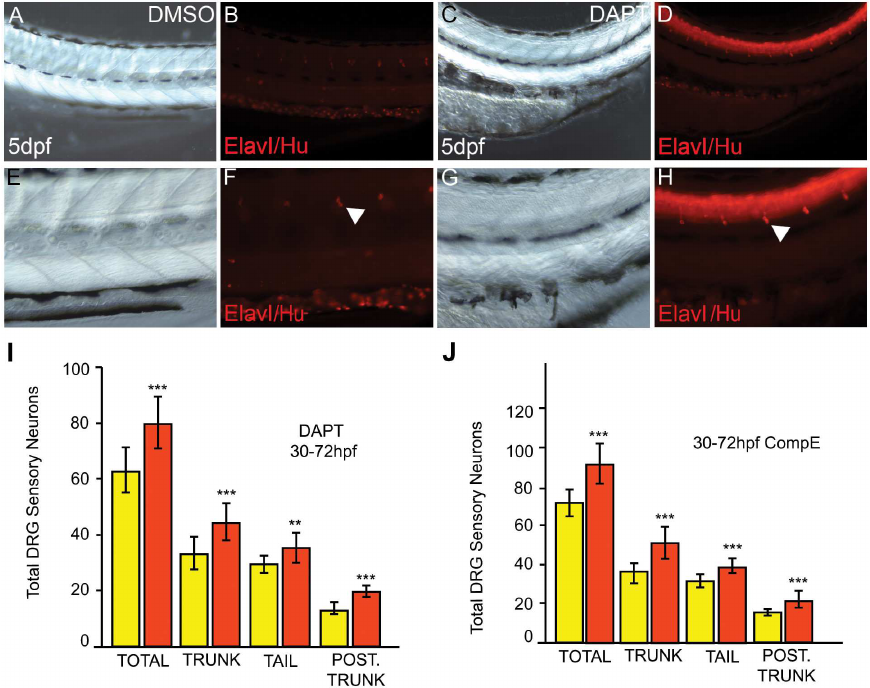
Fig 6. Notch inhibition phenocopies the sox10baz1DRG phenotype. A-H) Posterior trunks of WT embryos treated with 100 μ M DAPT from 30–72 hpf (C,D,G,H) and controls exposedto DMSO carrier alone (A,B,E,F). E-F show enlargements of A-D. Treated embryosshow dorsally-curved body axis (C). Immunofluorescence for Elav1/Hurevealedincreasednumbersof DRG sensory neurons(arrowhead). I,J) Quantitation of DRG sensory neuronsin 5 dpf embryos after treatment with 100 μ M DAPT (I, orange) or 100 μ M CompoundE (J, orange)from 30–72 hpf; comparedwith control DMSO-treated embryos (yellowin I and J), sensory neuronnumbers are significantly increased( *** )when Notch signalingis inhibited. While trunk refers to the entire somitic regionfrom posterior to the otic vesicle to the anus, tail refers to the post-anal body; posterior trunk refers to the 7 most posterior somatic segments dorsal to the yolk sac extension.N = 13 (Control, I), 13 (DAPT, I), 16 (Control DMSO, J) and 15 (Comp. E, J). Significanceof elevated numbers of neuronswas evaluatedby two-tailed Student’s t test ( ** , p < 0.01; *** , p <